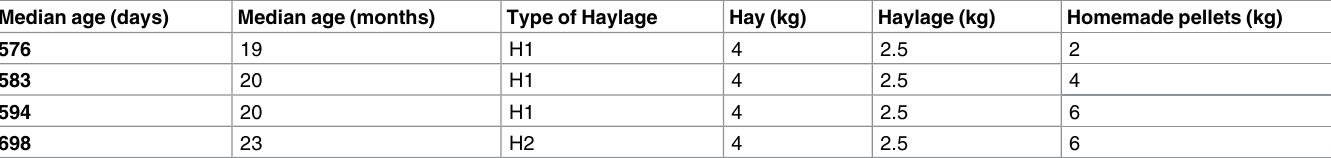
H1 and H2 indicate when a different hay batch was used. N =